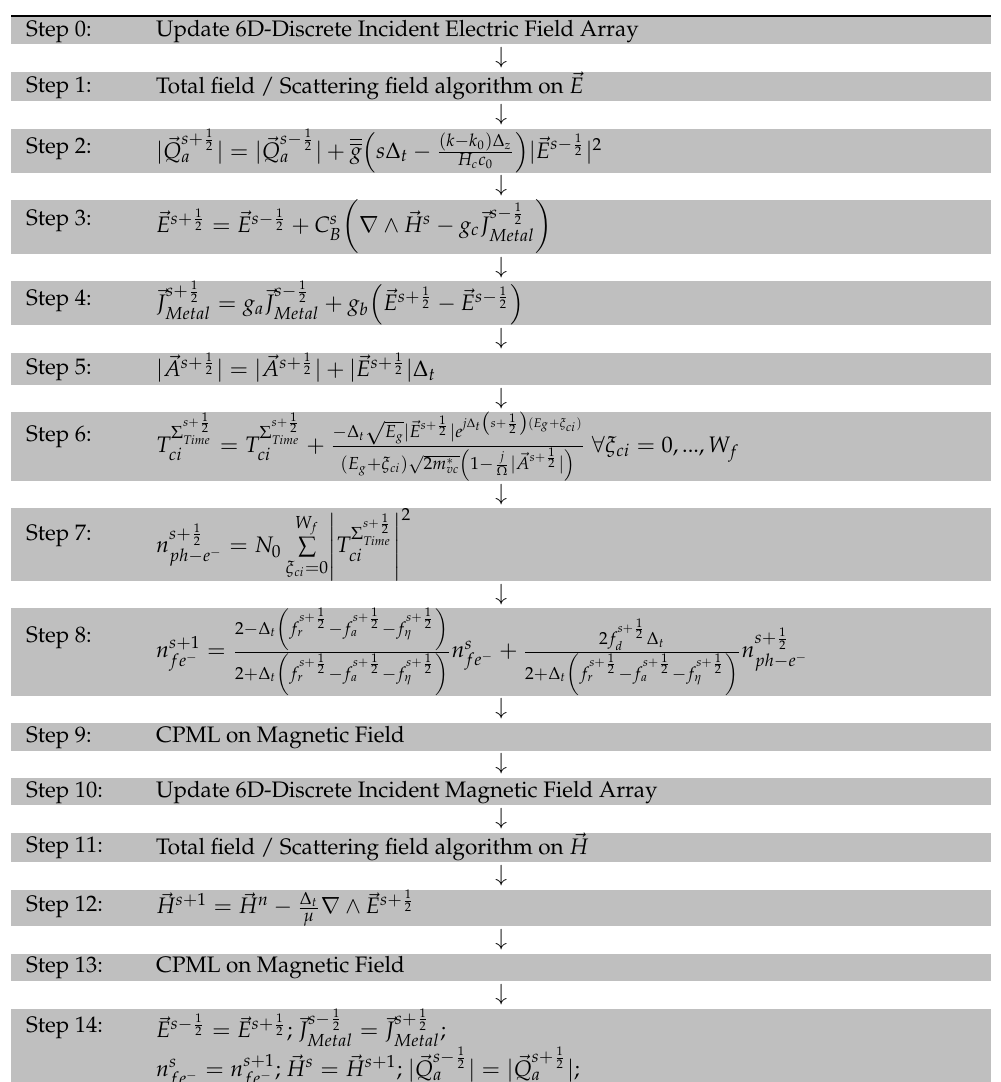
Table 1. The list of the new explicit algorithms added to the classical FDTD scheme in order to deal with the nonlinear effects. The current list of algorithms is depicted in the form of a flow chart and it is complemented by the global integration view shown in Figure